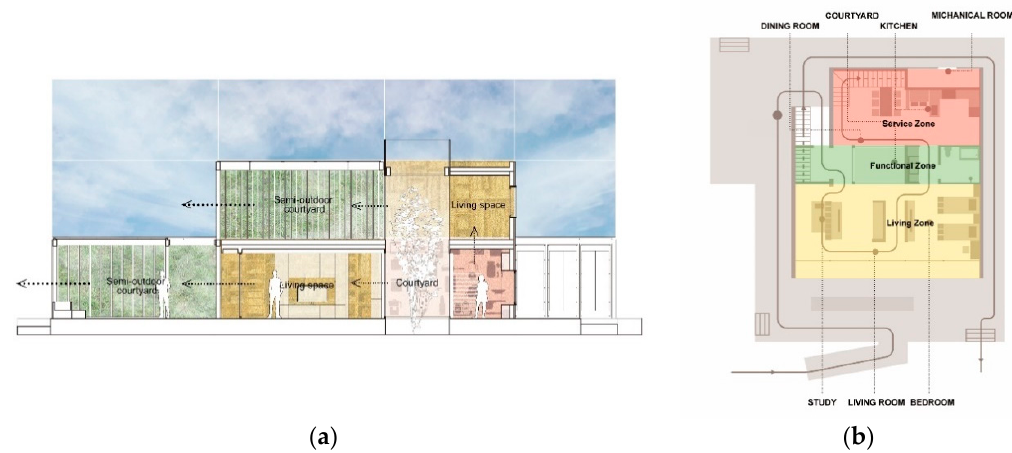
Figure 5. ( a ) Introduction of green ternary space; ( b ) ternary spatial plan for climate response.